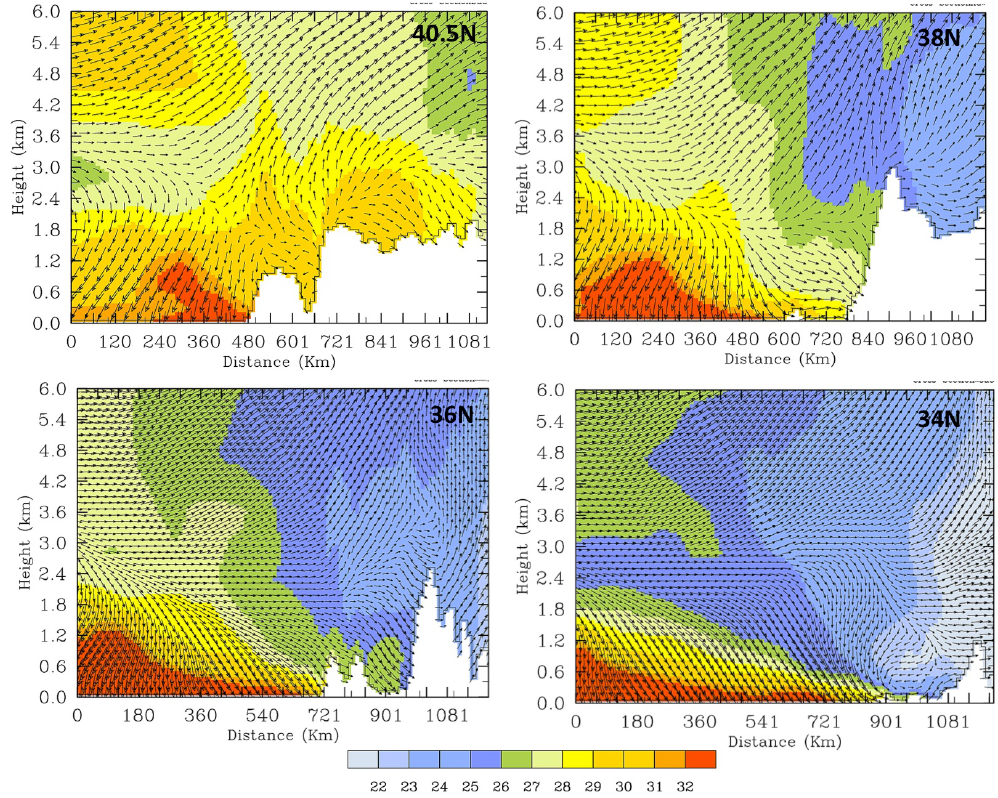
Fig. 10. Longitude – Altitude Cross Sections of CObc asia (ppbV) along 130–116 ◦ W at four different latitudes, averaged over 20 June–15 July 2008: 40.5 ◦ N (top left), 38 ◦ N (top right), 36 ◦ N (bottom left) and 34 ◦ N (bottom